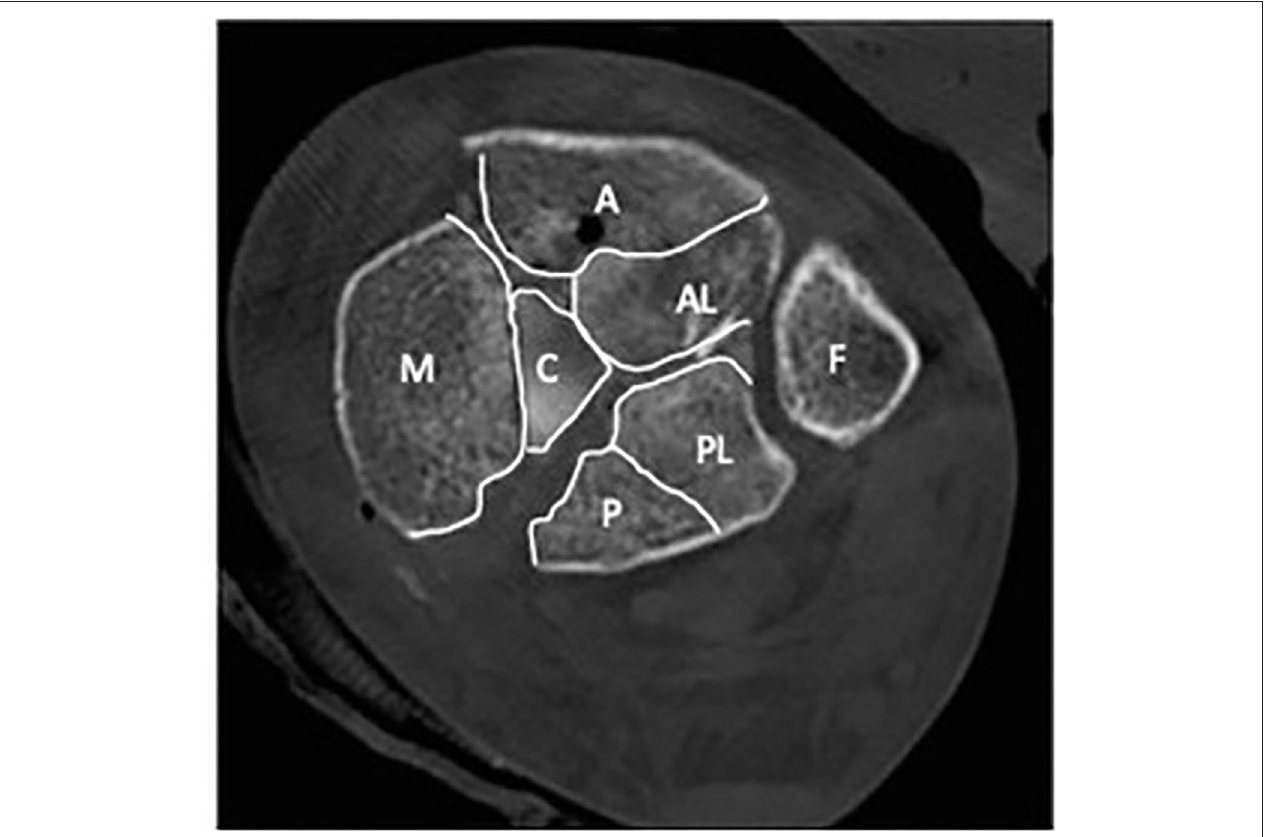
FIGURE 1 | An axial CT of the distal tibia showing the typical six fracture fragments. A, anterior fragment; AL, anterolateral fragment; P, posterior fragment; PL, posterolateral fragment; C, central die-punch fragment; M, medial fragment; F,